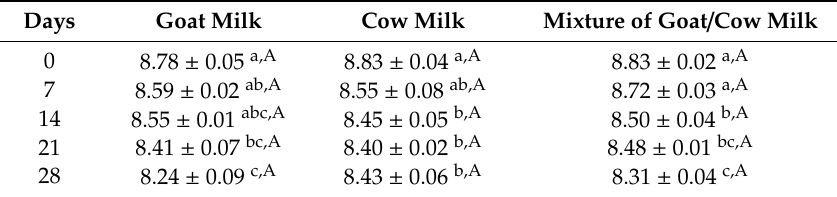
Table 5. Survival (log CFU g − 1 ) of Lactobacillus casei ATCC 393 in fermented milk during refrigerated storage at 4 ◦